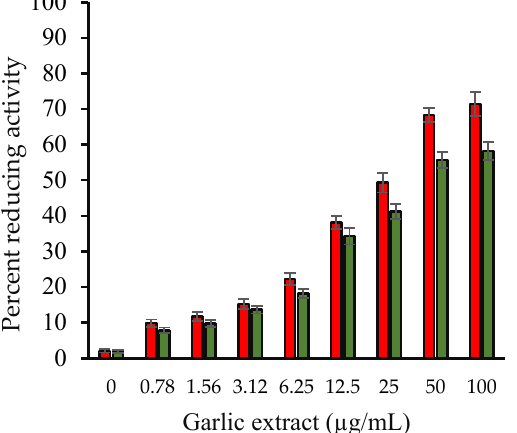
Figure 1. Percentage reducing power of ascorbic acid (red) and aqueous garlic extract (green). Samples in the histogram showed varying concentrations of ascorbic acid and garlic extract (0–100 µ g/mL). The y axis shows the corresponding percentage reducing power. The results are presented as means ± SEM ( n = 3). All the results (0.78–100 µ g/mL garlic extract) were statistically significant compared with the sample without extract (0 µ g/mL). Comparison between two groups was performed based on t test, and significance was defined as p < 0.05 .